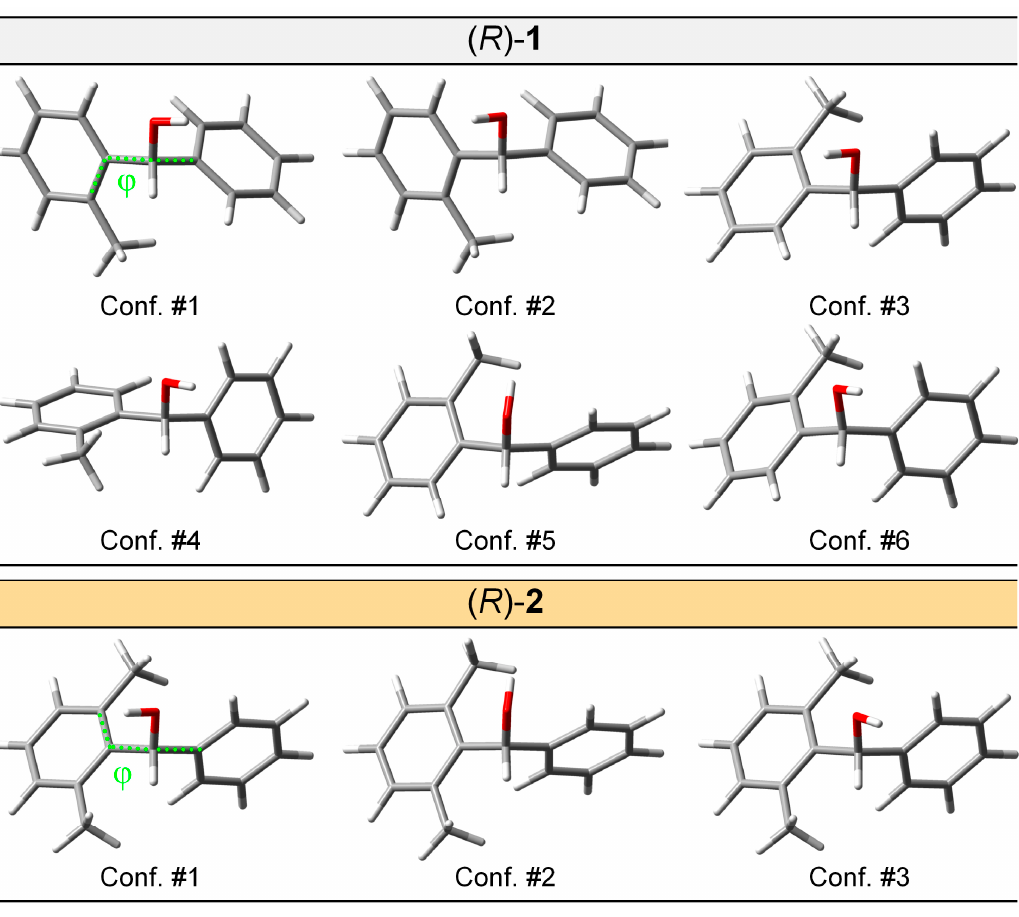
Figure 2. Low-energy conformers of compounds ( R )- 1 and ( R )- 2 calculated at ω B97X-D/def2-TZVP/PCM level. The dotted lines indicate the dihedral angle defined by carbon atoms 1 ″ –1–1 ′ –2 ′ . ECD calculations were run on compounds ( R )- 1 and ( R )- 2 with the time-dependent DFT (TDDFT) method [39] at the ω B97X-D/def2-TZVP/PCM level. It is well known that excited-state TDDFT